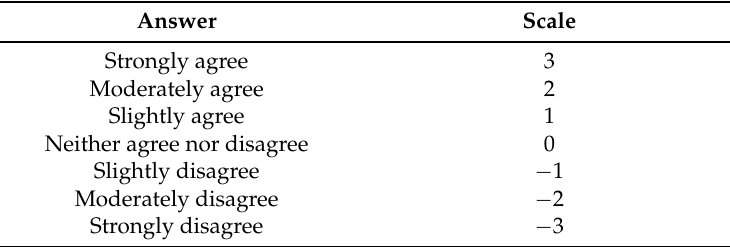
Table 2. Likert voting scale for questionnaries.